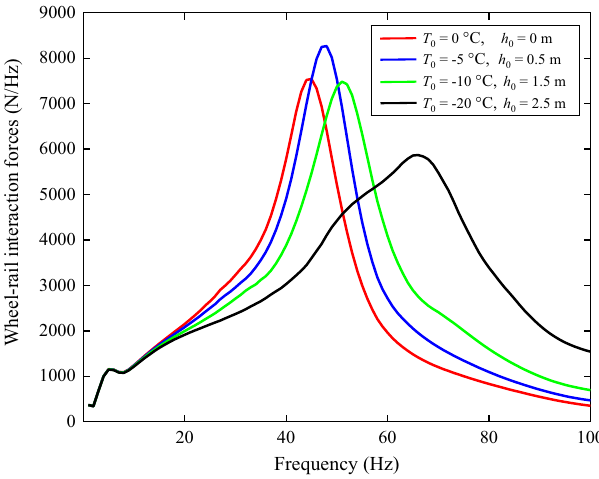
Figure 23. The spectra of wheel-rail interaction forces of the first wheelset.